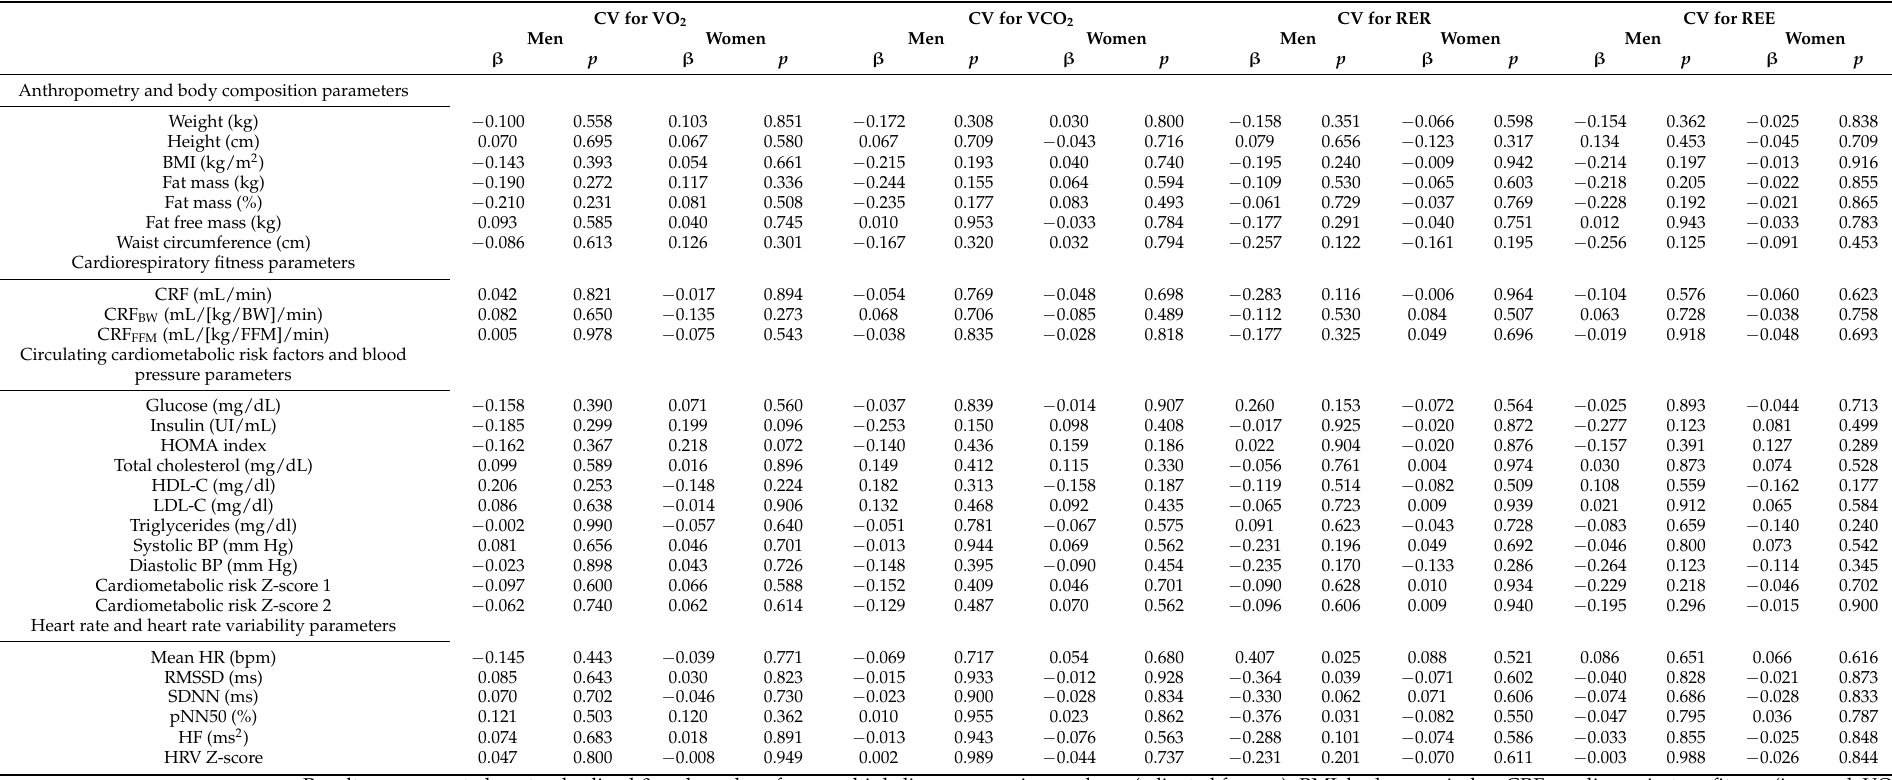
Table 2. Association between the intra-assessment resting metabolic rate (RMR) variability expressed as a coefficient of variation (CV) for each of the assessed indirect calorimetry parameters, i.e., the CVs for volume of oxygen consumption (VO 2 ), volume of carbon dioxide production (VCO 2 ), respiratory exchange ratio (RER), and resting energy expenditure (REE), and different health-related